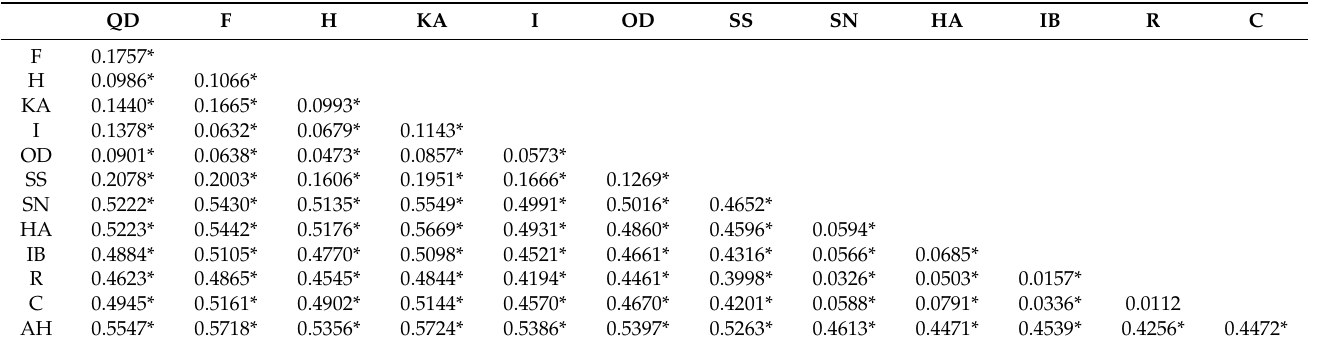
Table 4. Pairwise F ST values among 13 Ammodytes